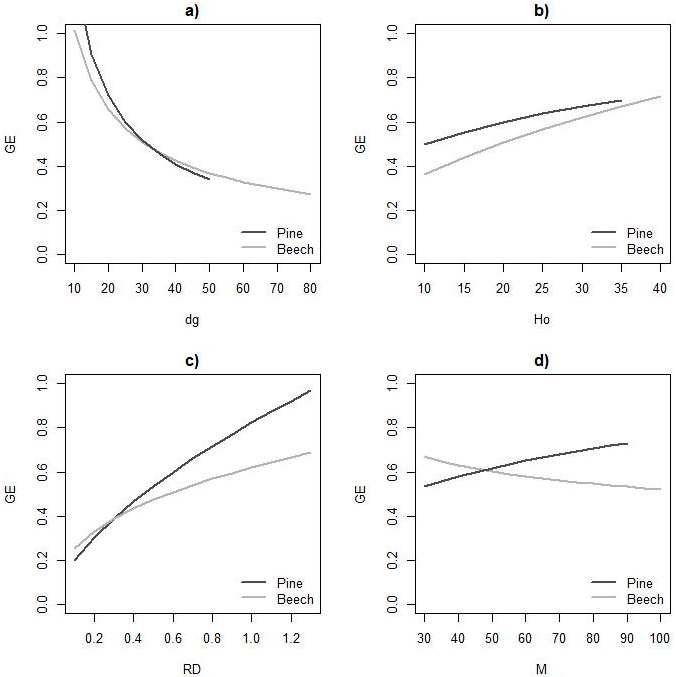
Figure 2. Influence of ( a ) quadratic mean diameter ( dg , cm); ( b ) dominant height ( H o , m); ( c ) relative density ( RD ) and ( d ) Martonne aridity index ( M , mm/°C) on the basal area growth efficiency (GE) of Scots pine and European beech when the inter-specific competition is null. Lines represent GE for the variable on the x -axis ranging between percentiles 1% and 99% of its values in monospecific stands. Other variables approximately equal to mean values: for pine dg = 25 cm, H o = 20 m, RD = 0.6 and M = 45 mm/ ◦ C; for beech dg = 30 cm, H o = 20 m, RD = 0.6 and M = 65 mm/ ◦